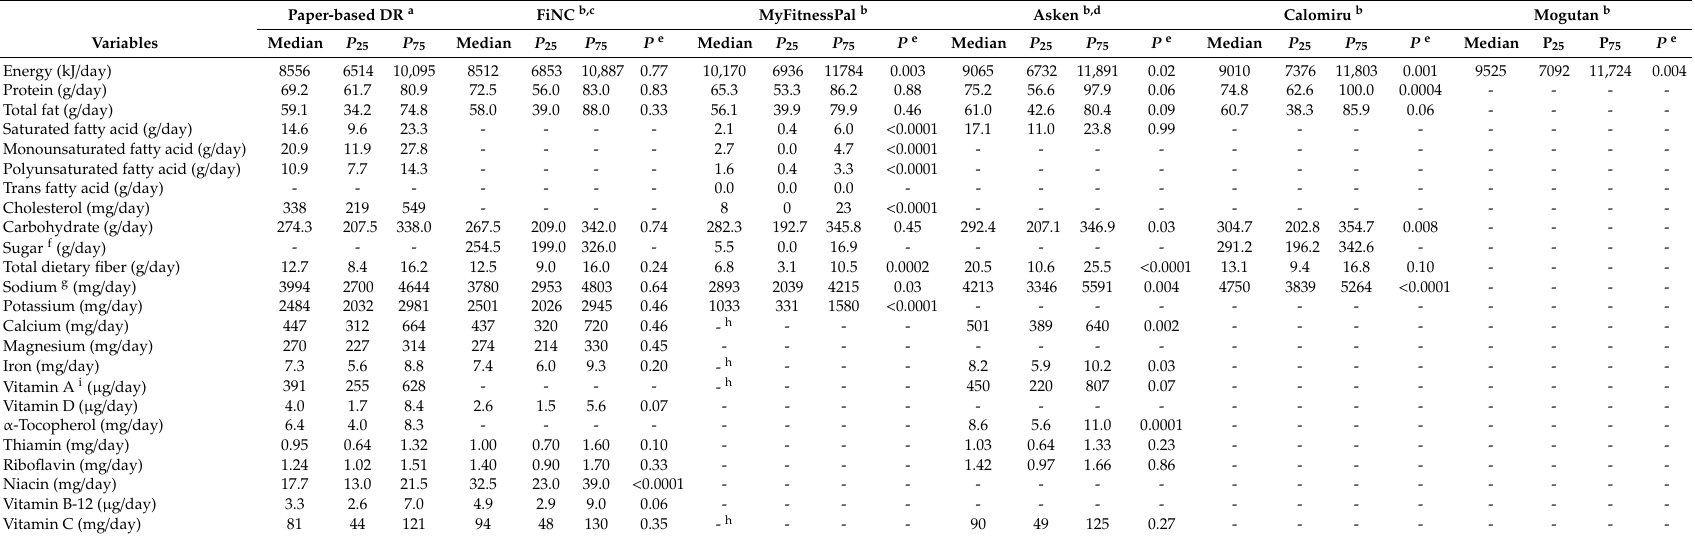
Table 2. Median intakes of energy and nutrients estimated by a one-day paper-based dietary record (DR) and those estimated by the five diet-tracking applications among Japanese adults ( n =